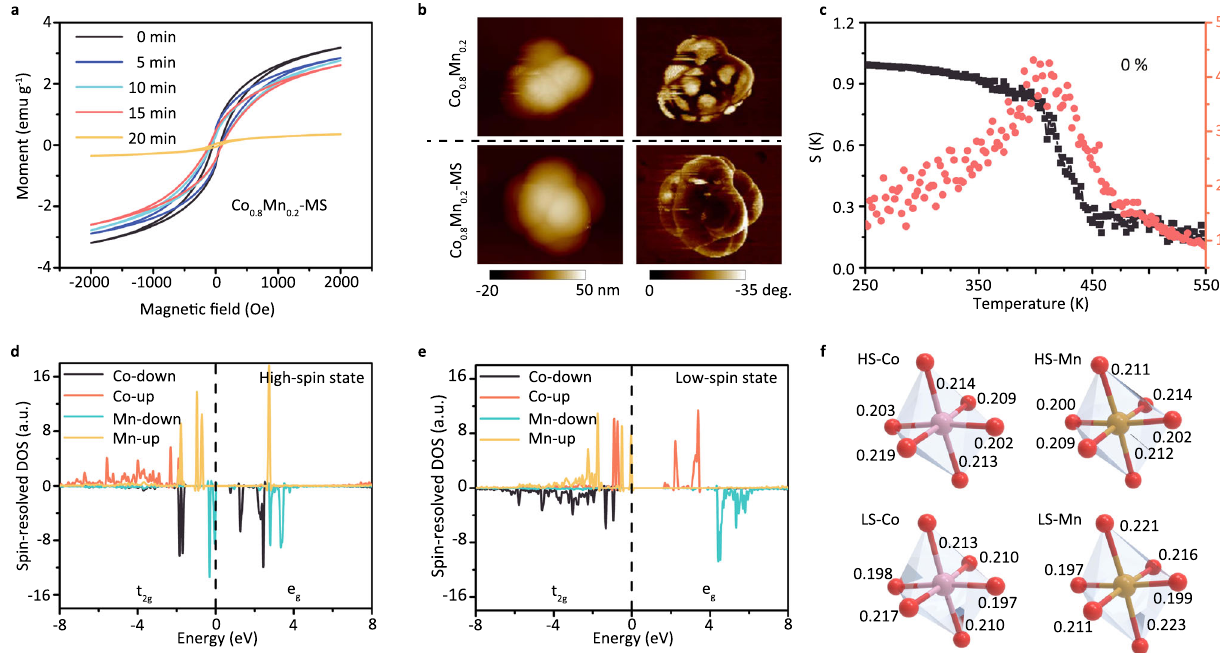
Fig. 3 Magnetic structure characterization. a Room temperature magnetic hysteresis loops of Co 0.8 Mn 0.2 -MOF with different MS time. b The atomic force microscopy topographical (left) and magnetic force microscopy phase (right) image of the Co 0.8 Mn 0.2 -MOF with and without MS. c The speci fi c heat C v and spin structure factor S ( k ) as a function of temperature. The spin-resolved PDOS of Co 0.8 Mn 0.2 -MOF with HS d and LS e con fi guration. f The optimized structure of Co 0.8 Mn 0.2 -MOF with HS and LS con fi